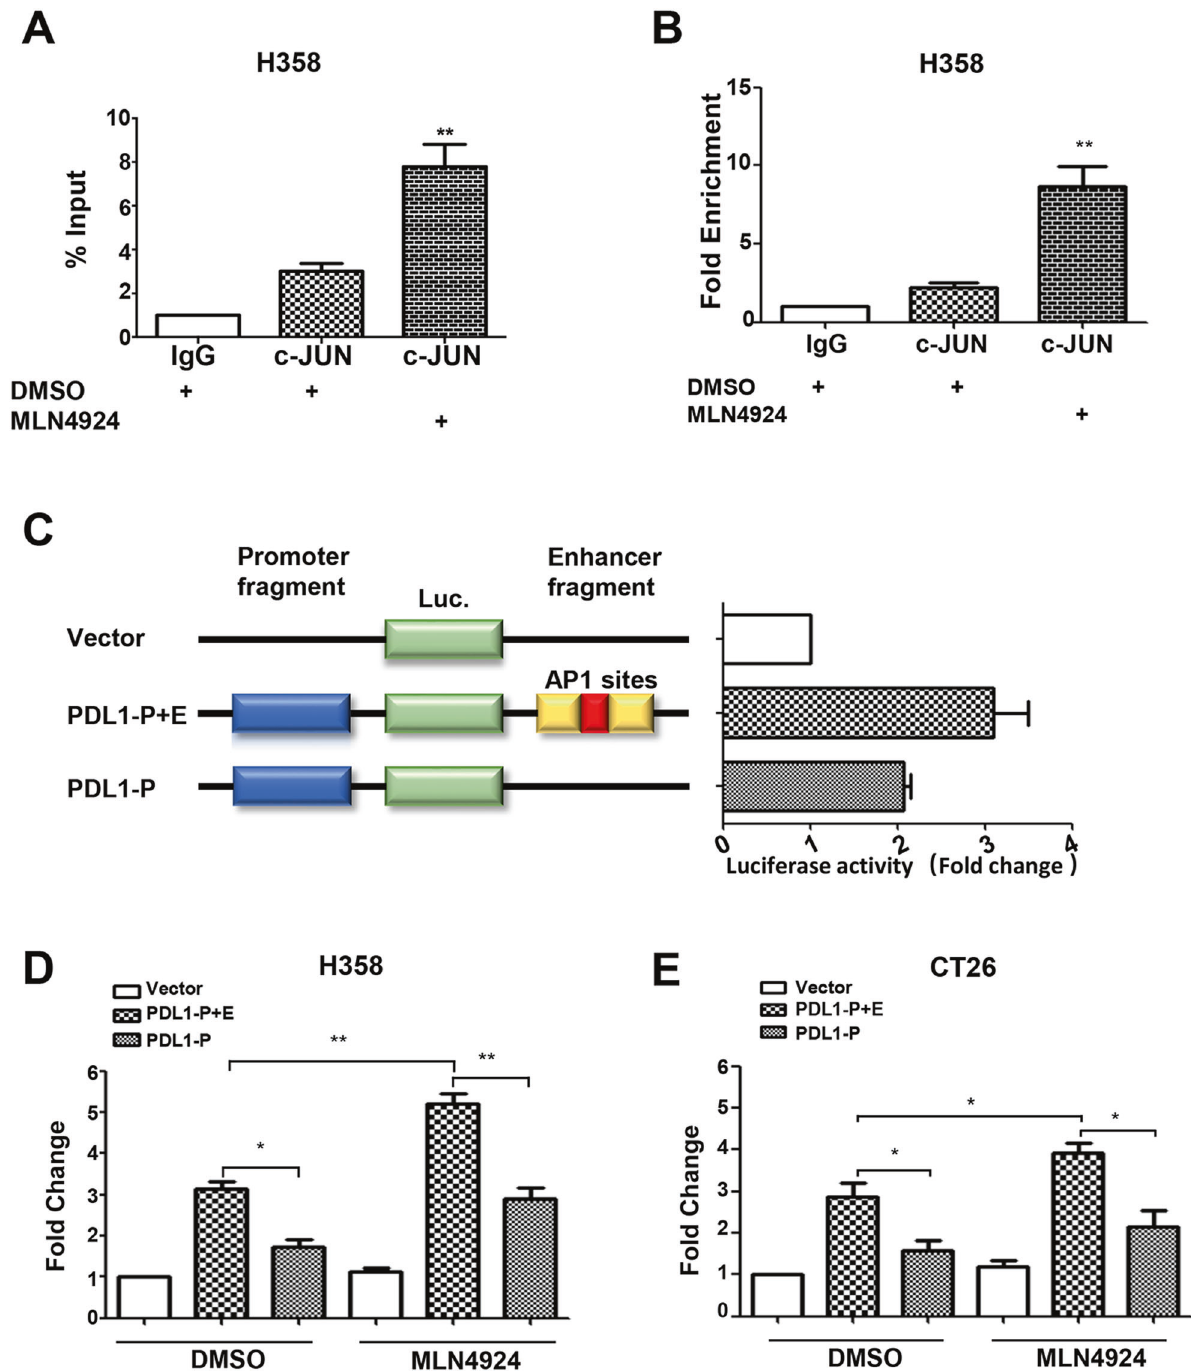
Fig. 3 AP-1 activity controls the MLN4924 induction of PD-L1 expression. A , B c-JUN bound to the PD-L1 enhancer sequence and the binding was signi fi cantly enhanced by MLN4924 treatment. H358 cells were treated with MLN4924 (0.5 μ M) for 24 h, followed by ChIP-coupled PCR assay. The results were represented as % input ( A ) and Fold Enrichment ( B ). C AP-1-containing enhancer element increased PD-L1 promoter-driven luciferase activity. Constructs include the empty pGL3 vector, the pGL3 vector with the promoter cloned upstream of the luciferase gene alone (PDL1-P), the promoter with the wild-type enhancer cloned downstream of the luciferase gene (PDL1-P + E). D , E MLN4924 induction of PD-L1 depends on AP-1 binding site. H358 ( D ) and CT26 ( E ) cells were transfected with the indicated plasmids for 24 h, and then treated with MLN4924 (0.5 μ M) for 24 h, followed by luciferase-based transcriptional assay. Shown are mean ± SEM of three independent experiments. p < 0.05 (*), p < 0.01